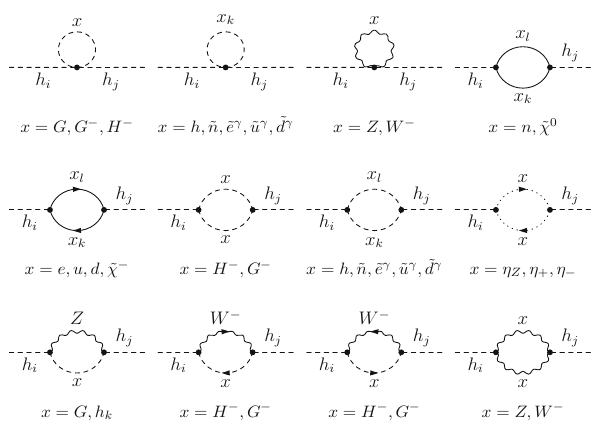
Fig. 1 GenericFeynmandiagramscontributingtotheone-loopneutral Higgs self-energies. The indices k , l take several sets of values depend- ing on the fields that they go with: k , l = 1 ,..., 5 for x = h , ˜ χ 0 , k , l = 1 ,..., 3 for x = e , u , d , ˜ e , ˜ u , ˜ d , k , l = 1 ,..., 18 for x = ˜ n and k , l = 1 ,..., 9 for x = n . The index γ denotes the left- and right- handed scalars. Color indices for the quarks and squarks are suppressed